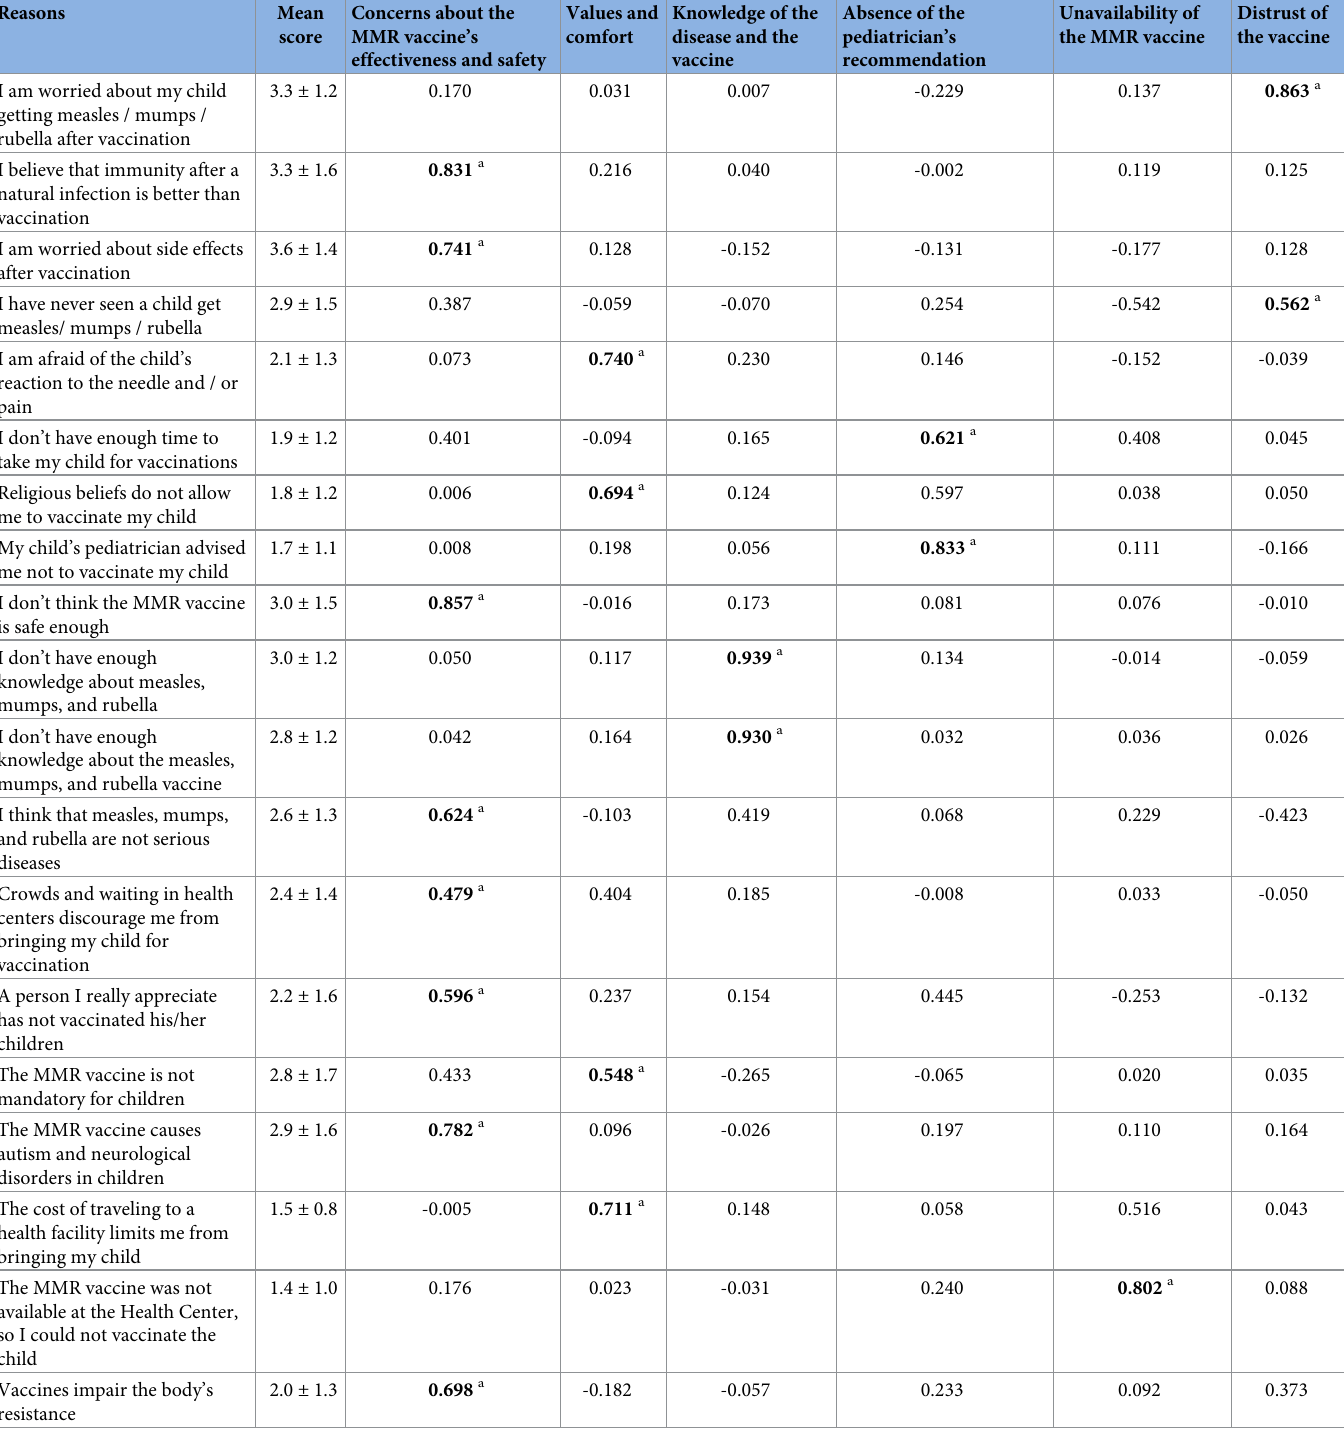
Table 2. Exploratory factor analysis of the reasons for not receiving the MMR vaccine for pre-school children.